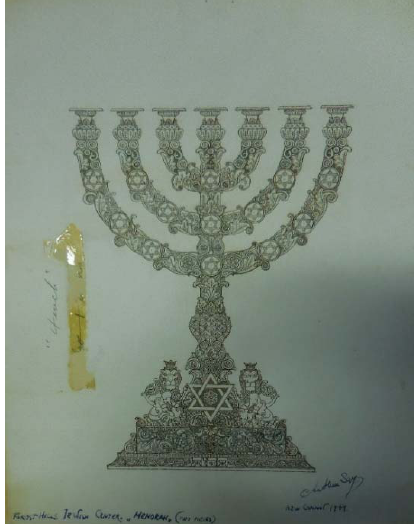
Figure 6. Arthur Szyk, ink sketch for the Menorah, 1949.